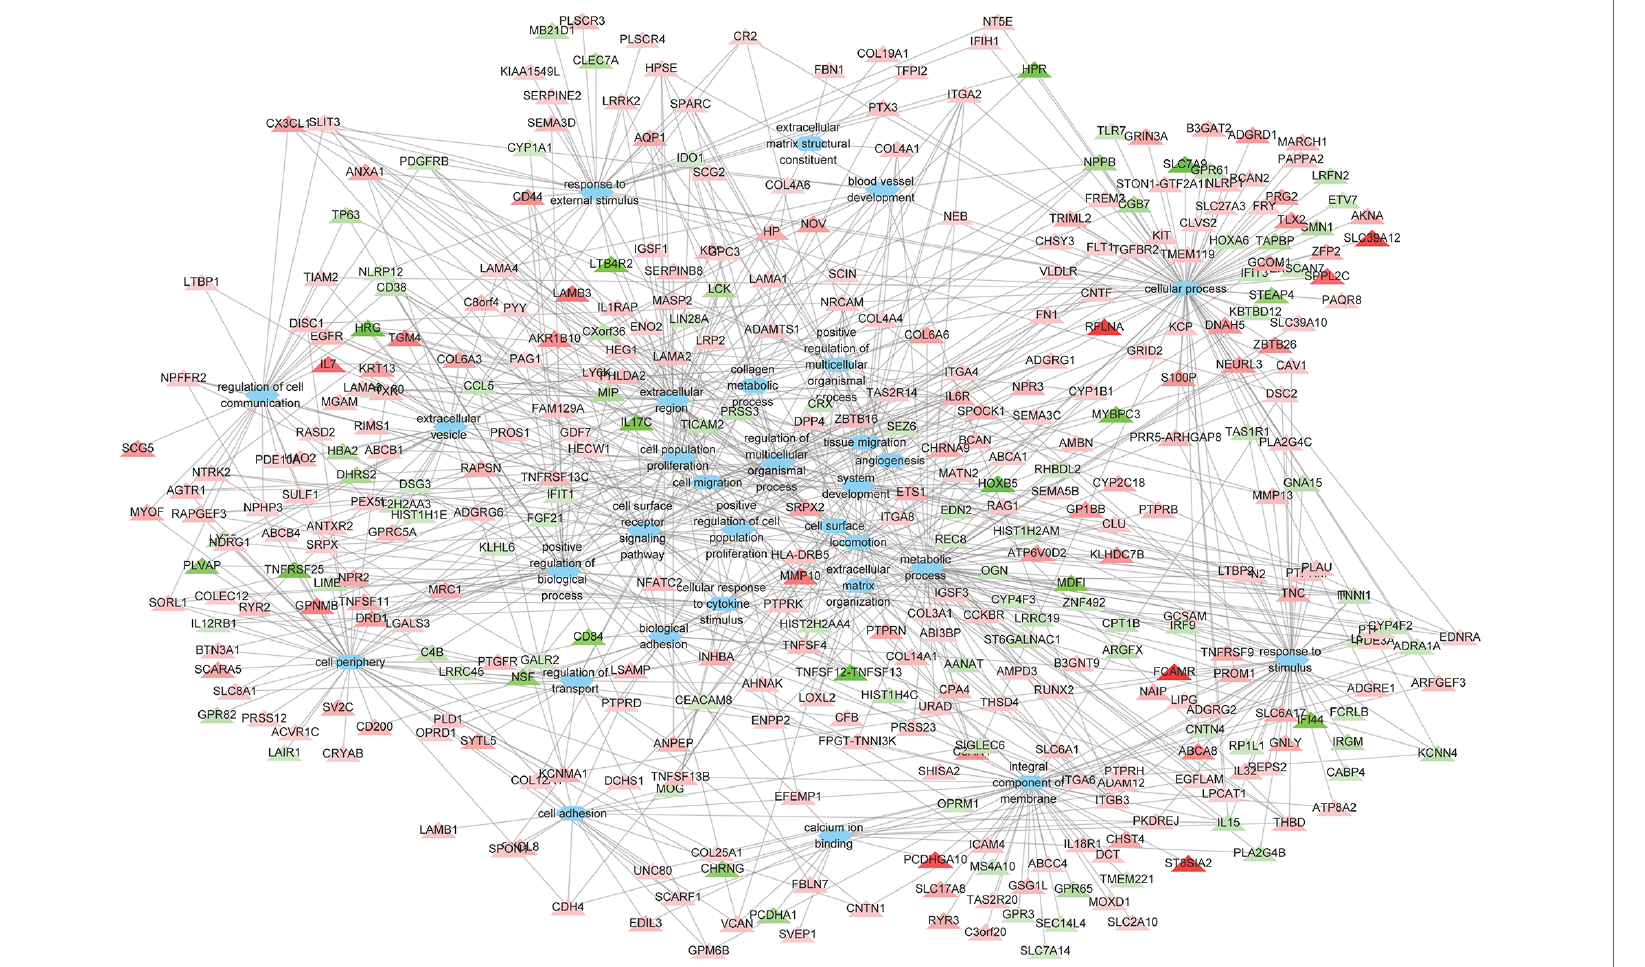
FIGURE 4 | The relationships between the DEGs and the top 30 enriched GO terms. The 373 DEGs were enriched in the top 30 enriched GO terms. Triangles represent the DEGs and ovals represent the GO terms. Red and green triangles represent upregulated and downregulated DEGs, respectively. The details of DEGs are listed in Supplementary Table S2